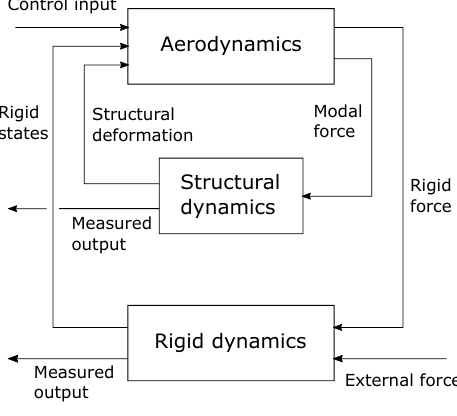
Figure 5. Subsystem